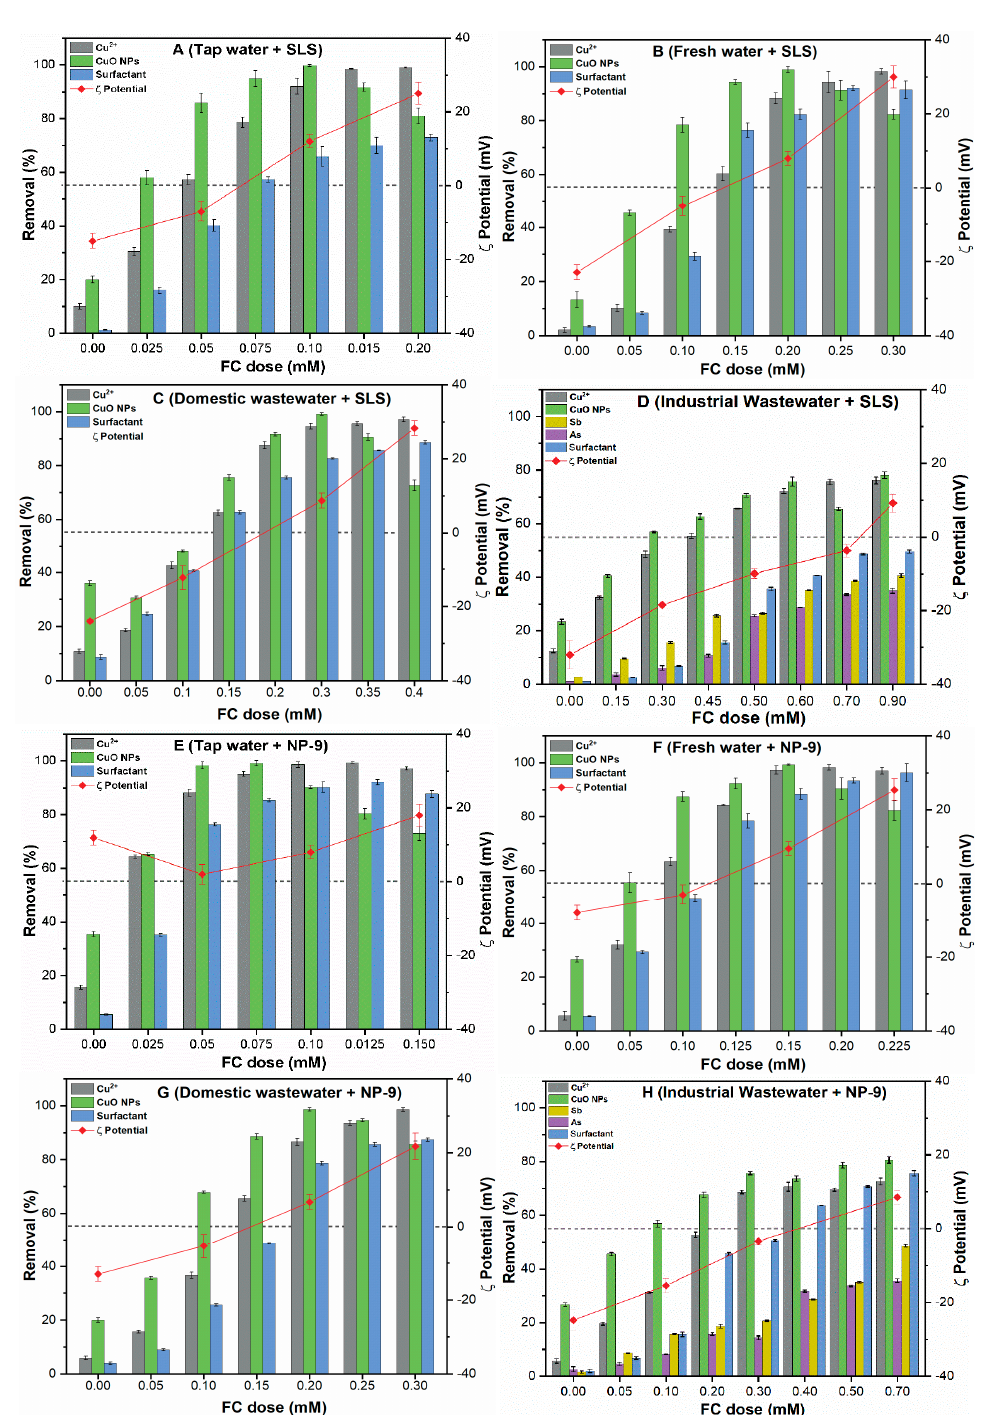
Figure 7. Removal of CuO NPs, Cu 2+ , surfactant, from environmental waters ( A–H ), as a function of FC coagulant dosage with corresponding ζ potential.